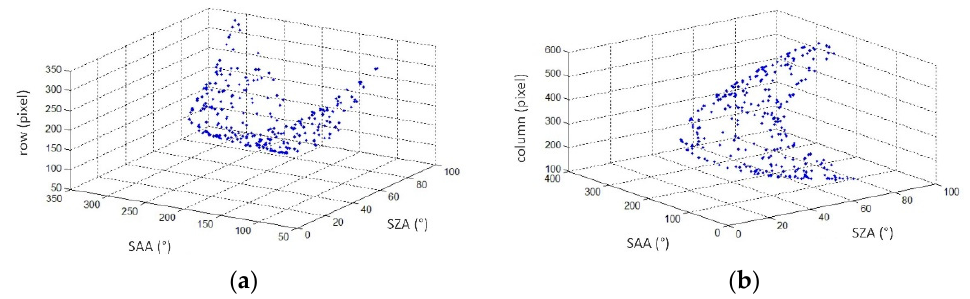
Figure 5. Row-scatter and the column-scatter plots: ( a ) The row-scatter plot; ( b ) the column-scatter